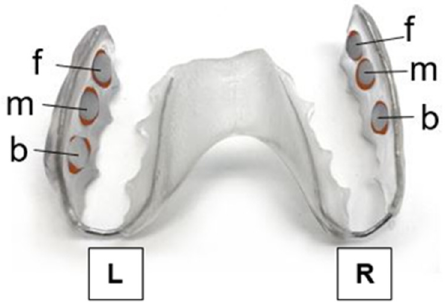
Figure 1. Individual upper-jaw acrylic appliance with the enamel slabs placed in different locations on each side in front (f), in the middle (m), or at the back (b). The samples were positioned on the right (R) and left (L) in the splint. The exposed surfaces were attached to the splint with adhesive wax.